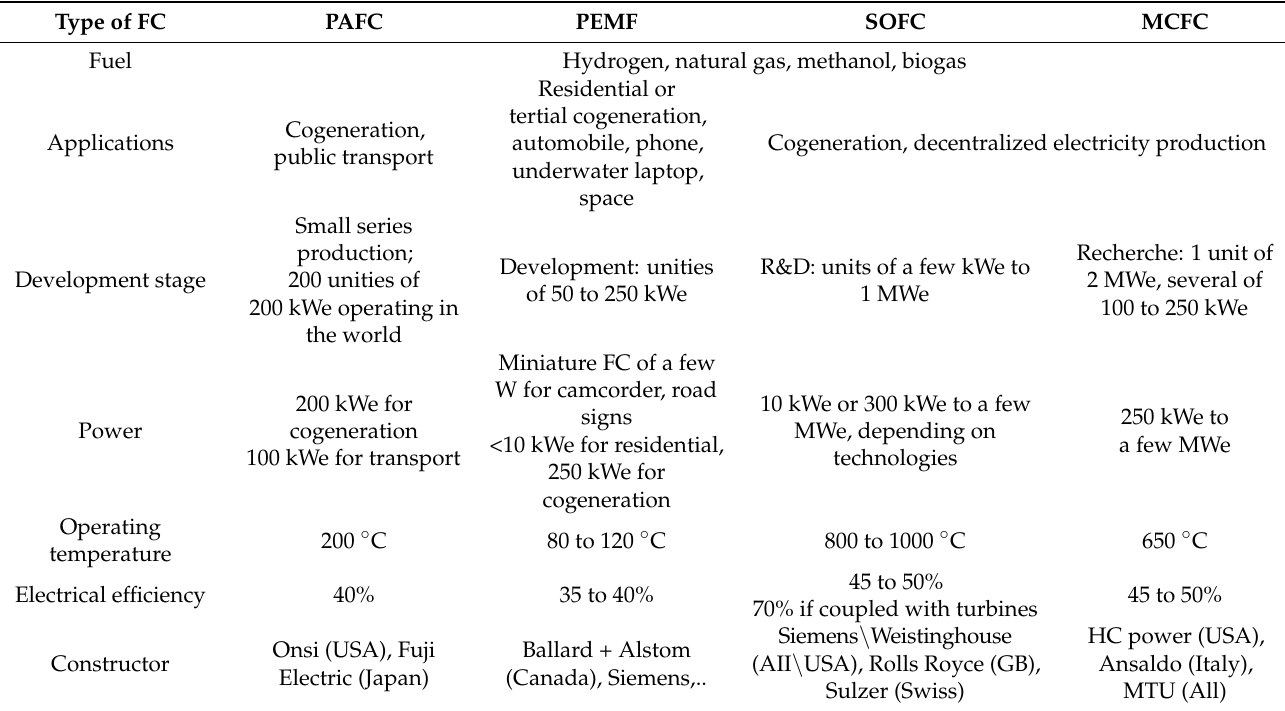
Table 2. Different types of Fuel Cells and their performance.